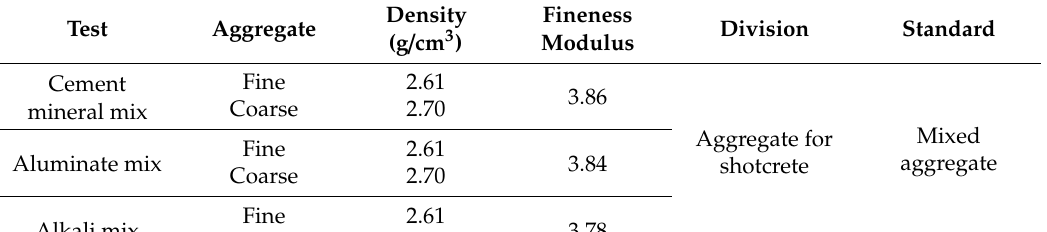
Table 1. Physical properties of fine and coarse aggregate.